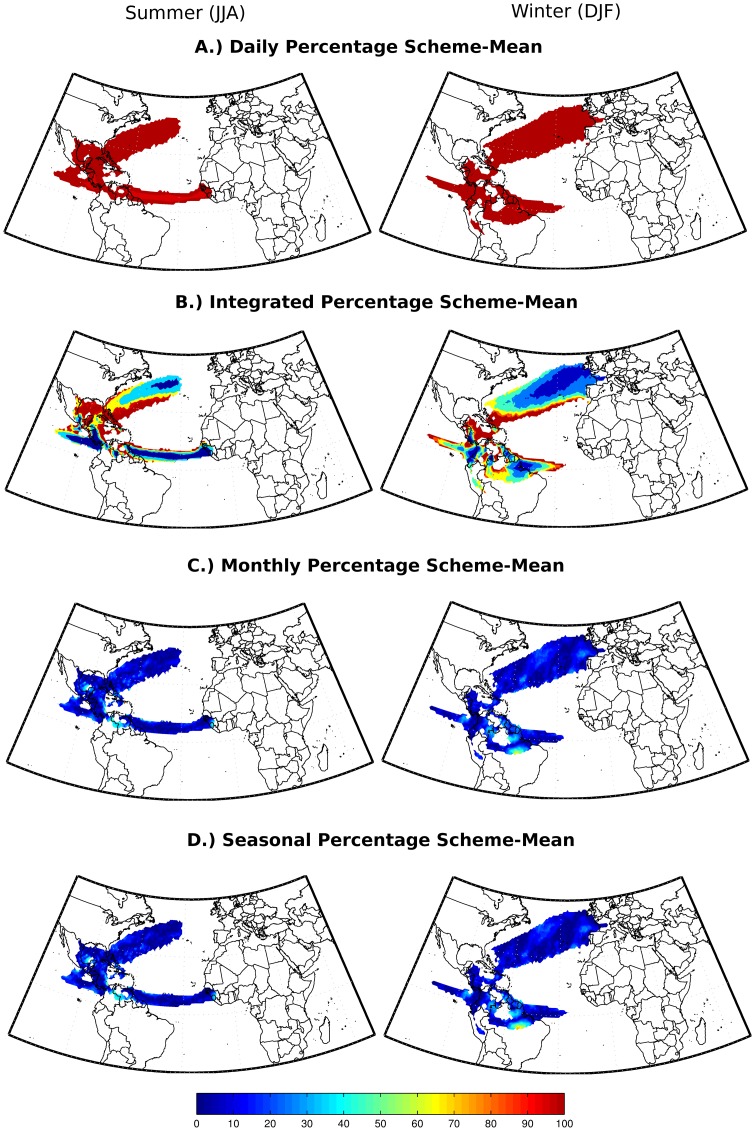
Percentage magnitude of the differences in mean net precipitation with respect to the 21-year average (climatological scheme-mean) for each one of the approaches.